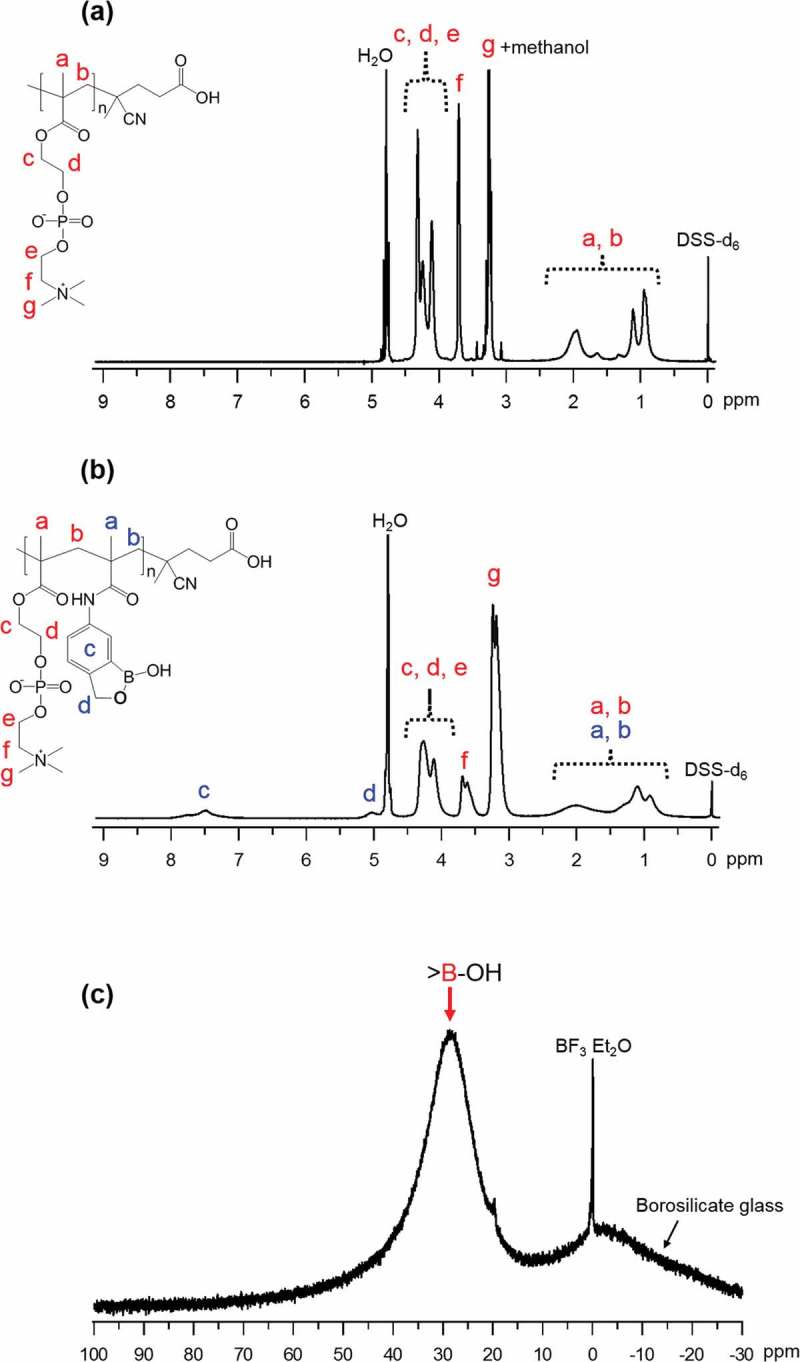

1H-NMR spectra of (a) poly[MPC] and (b) poly[MPC-co-MAAmBO] in D2O solvent, and (c) 11B-NMR spectrum of poly[MPC-co-MAAmBO] in CD3OD solvent. DSS-d6 and BF3·EtO2 were used as the internal and the external standards, respectively.